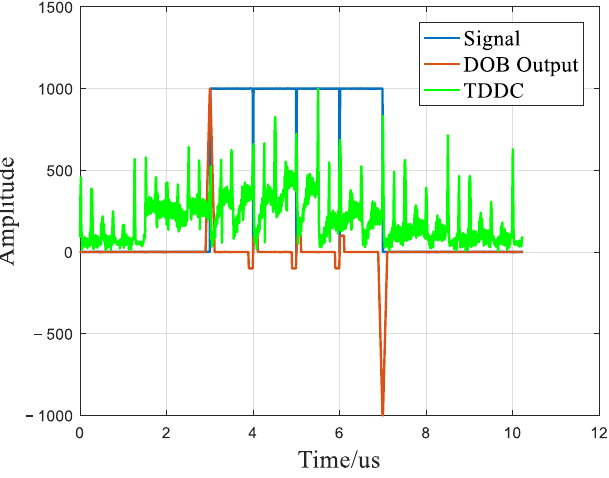
Figure 9. TDDC result compared with DOB result.